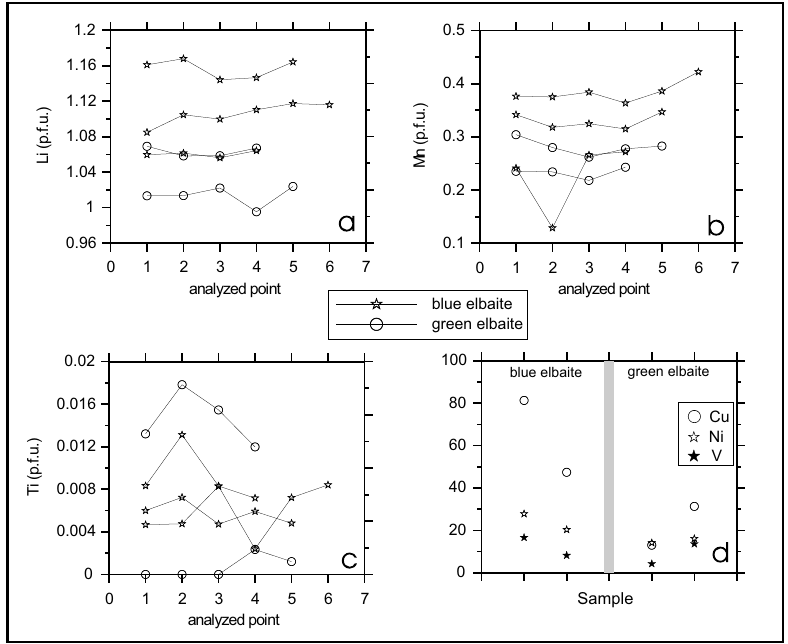
Fig. 6 – Compositional variations of studied blue and green elbaites. (a) through (c): dif- ferent analyzed points in single grains; Li, Mn, Ti, and Fe obtained by electron microprobe; (d) whole rock; Cu, Ni and V obtained by